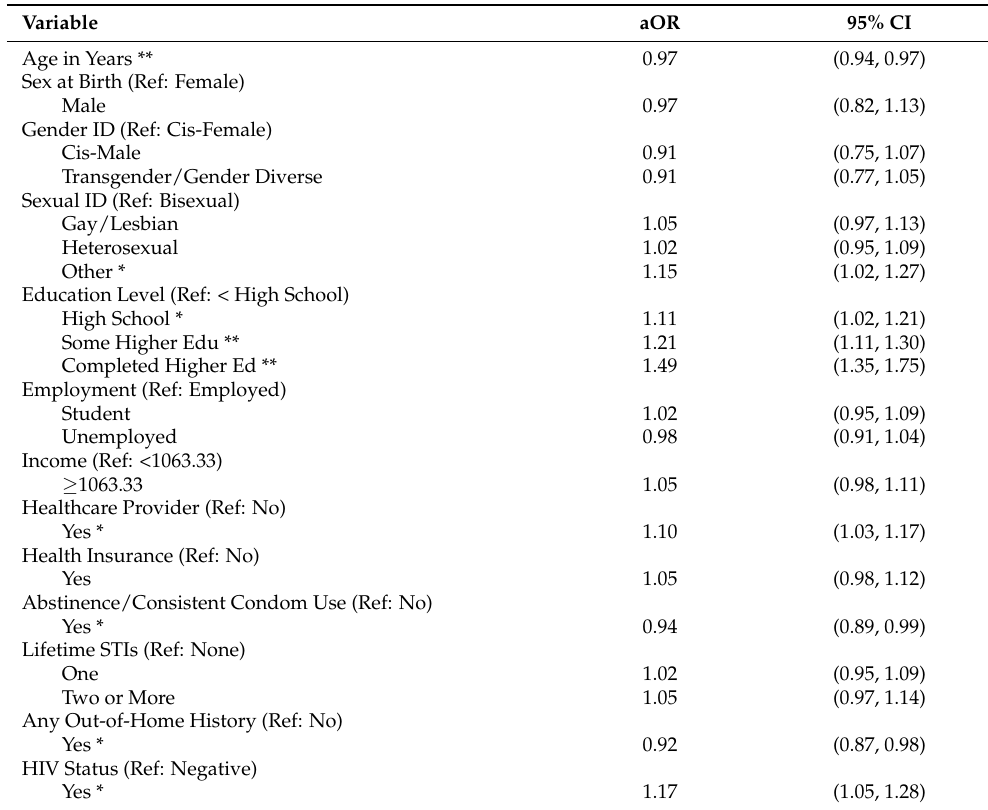
Table 3. Results of the multivariate analyses examining the rates of HPV vaccinations adjusted for a variety of sociodemographic factors and risk